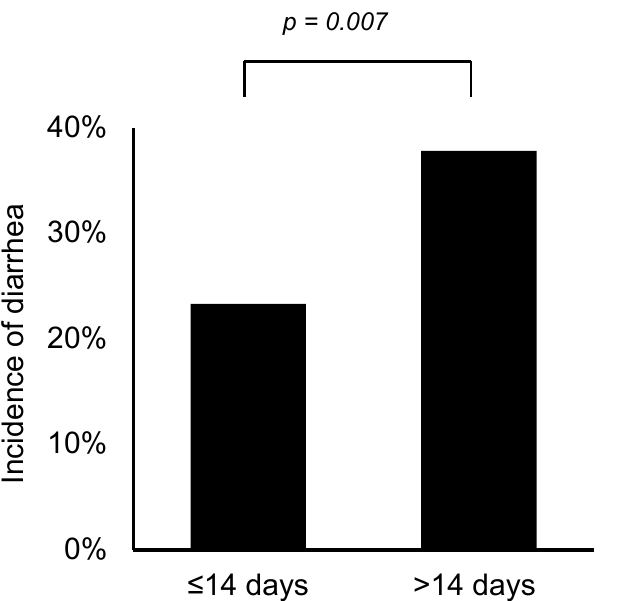
Figure 3. Incidence of diarrhea according to duration of opioid use before starting naldemedine.